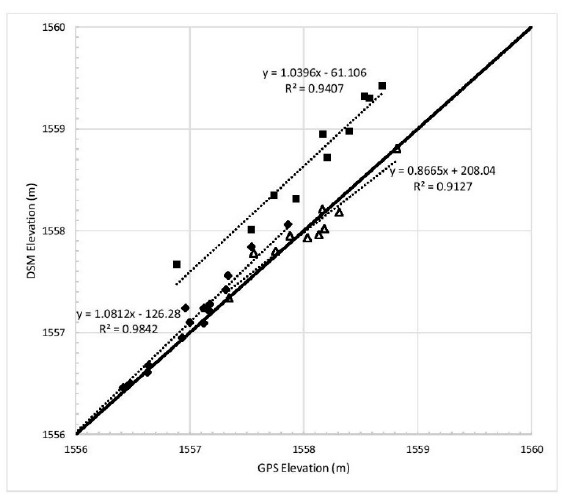
Figure 10. Water surface elevation from SfM DSM vs GNSS measurement elevation. Squares, diamonds and triangles represent June, July and September flight surveys, respectively.